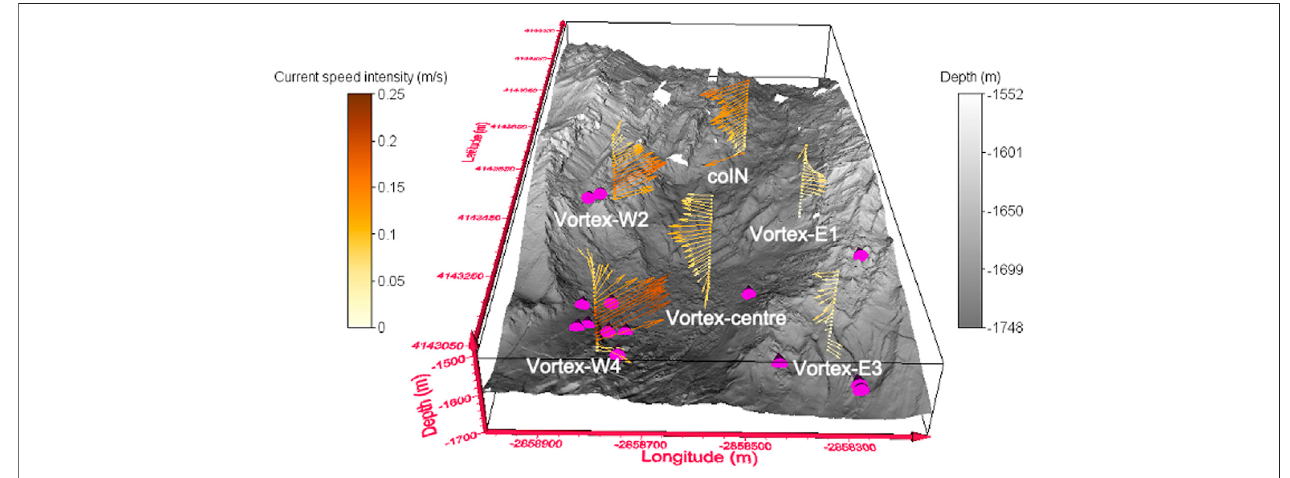
FIGURE 5 | Pro fi les of current speed intensities and direction (acquired via ADCP) at the six CTD casts reported on the top of 3D bathymetric map of the Lucky strike hydrothermal fi eld. Active hydrothermal vents are indicatedby pink cones. Refer to Supplementary Table S3 for current intensity valuesand to Supplementary Figure S2 for another current pro fi les